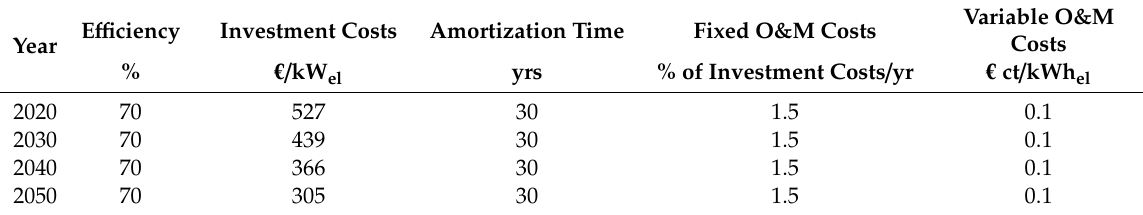
Table 4. Assumed economic and technological parameters for local electrolyzers used for hydrogen cars